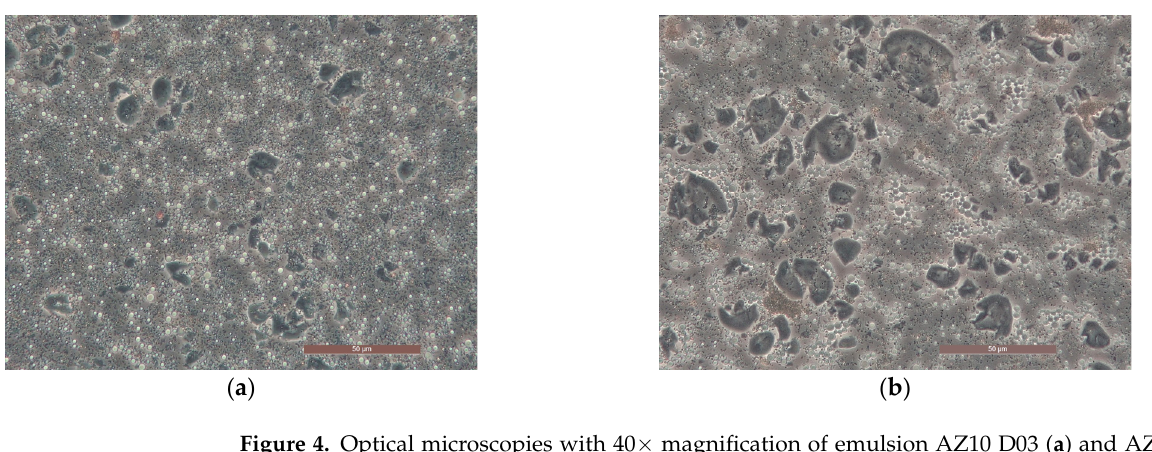
Figure 5. Optical microscopies with 40× magnification of emulsions prepared with A-Z association (ratio 1:1), 40% w/w of oil phase O without ( a ), and with the polysaccharide D at 0.1% w/w ( b ), and D at 0.5 % w/w ( c ).